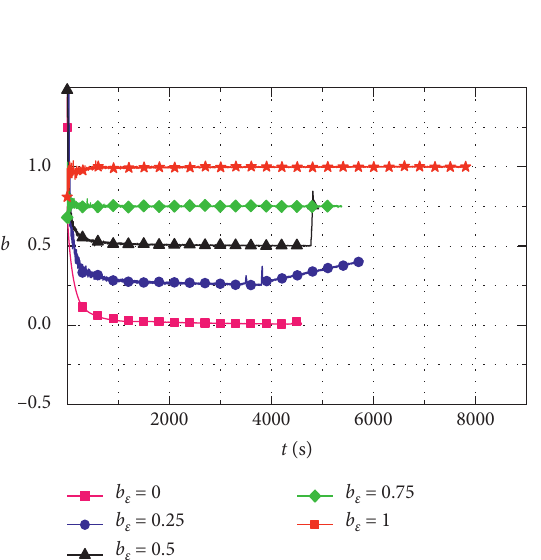
Figure 6: Strain path control.